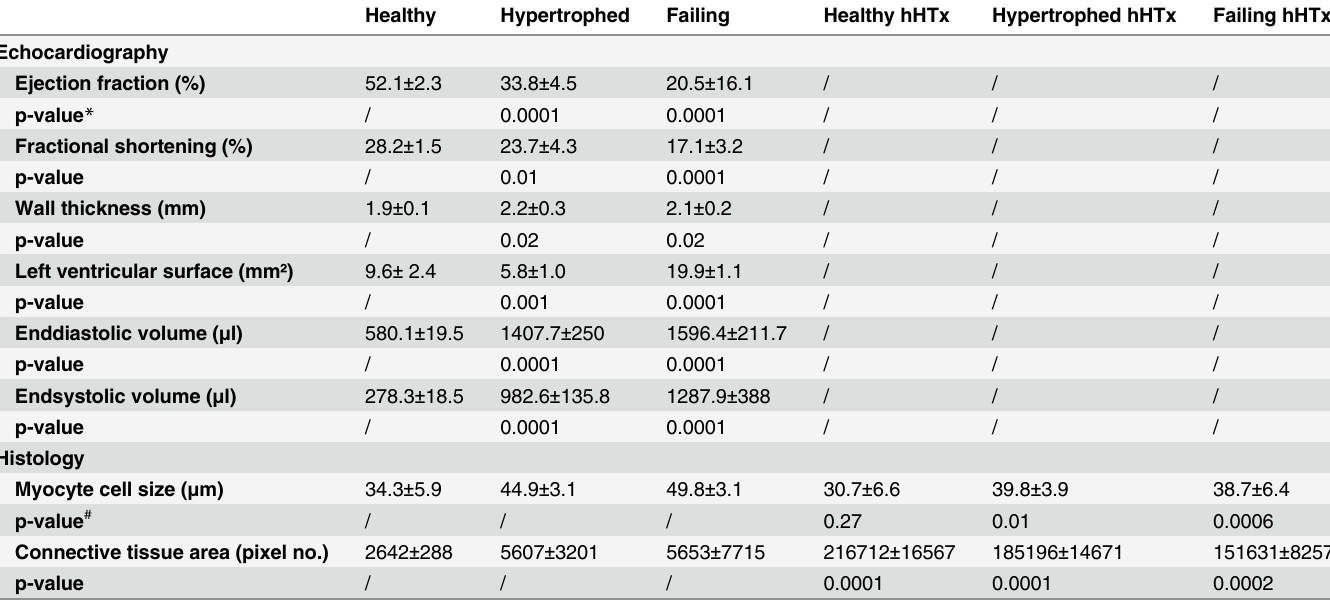
Table 1. Echocardiographic